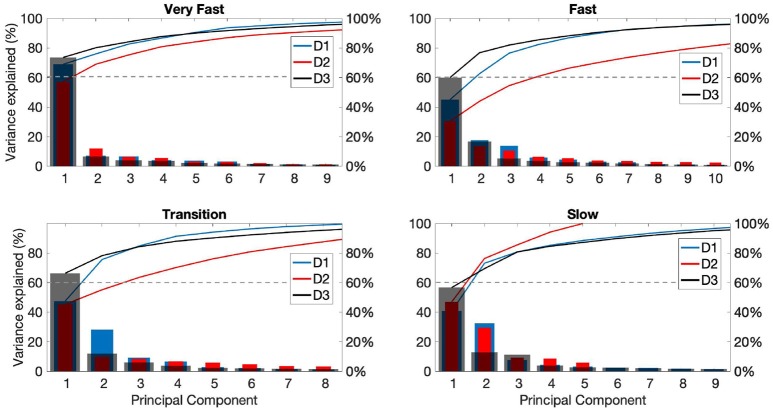
Principal component (PC) analysis results for drummers D1-3 for the different playing phases: fast (top panel), transition (middle panel), and slow (bottom panel). Each panel shows the percentage of variance accounted for by PCs 1-10 for players D1 (blue), D2 (red), and D3 (gray).